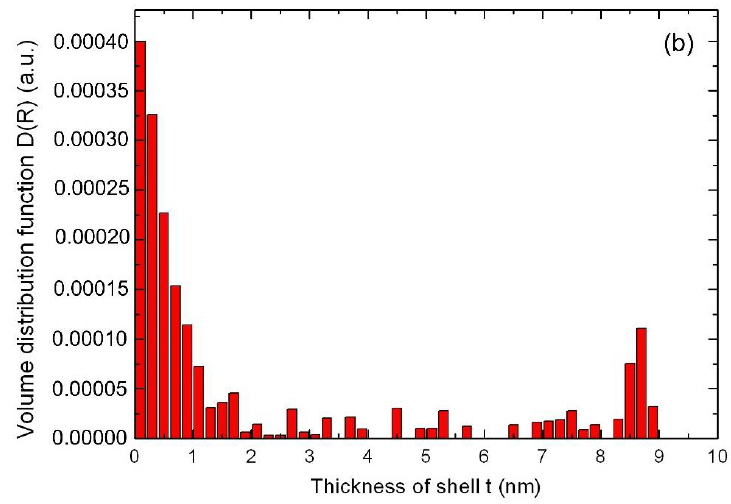
Figure 3. The size distribution function of Ag/Au (3:1) nanoparticle for the core ( a ), and the shell thickness distribution ( b ), calculated by the Monte-Carlo method in the core-shell model.